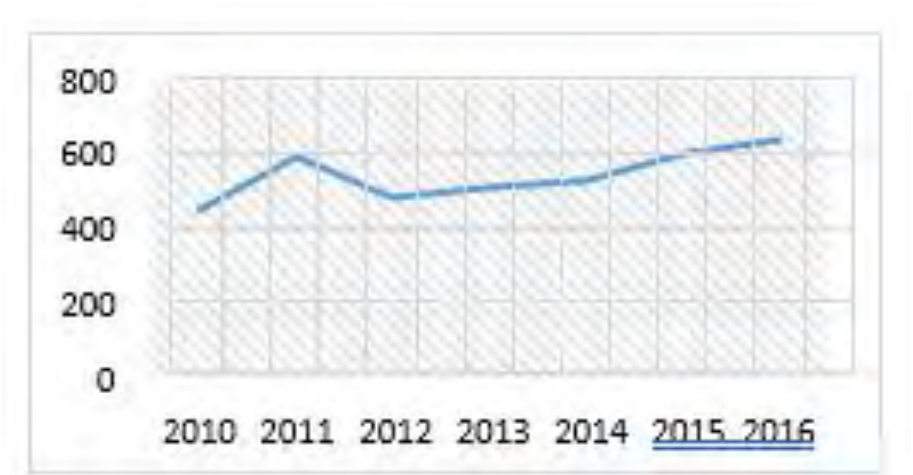
Figure 5. Growth in LEED forExisting Buildings: Operations & Maintenance Certified Space (Yudelson,